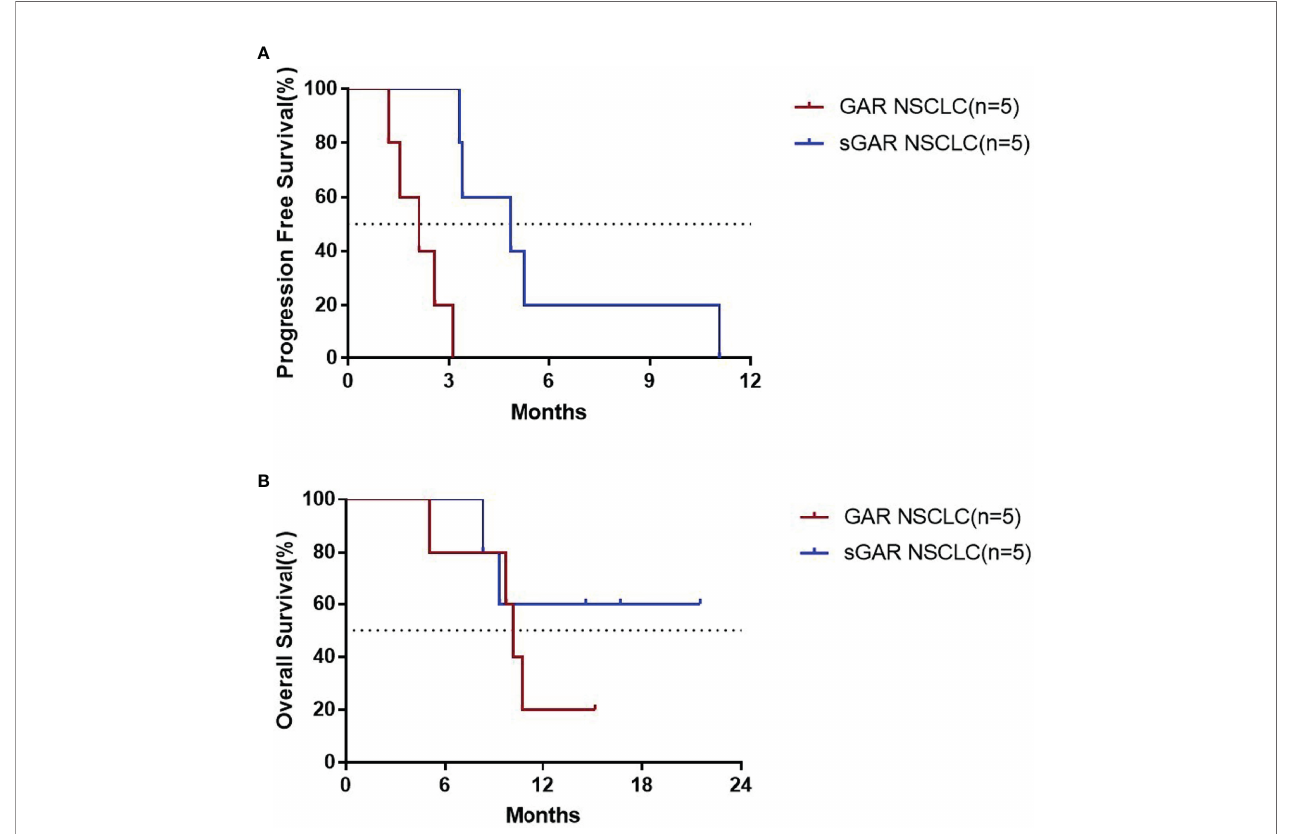
FIGURE 3 | PFS (A) and OS (B) for the patients with lung cancer who completed the 4 vaccinations for immune